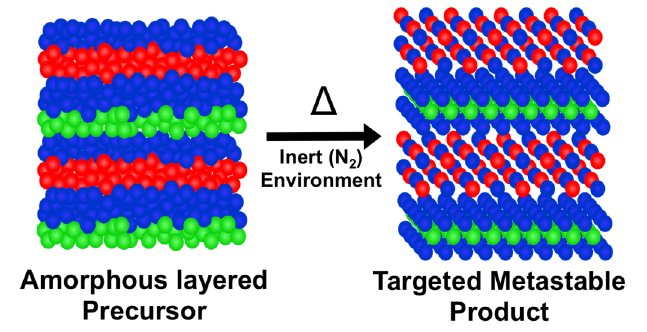
Figure 10. Modulated elemental reactant synthesis. Control of local composition and structure allows for the self-assembly of amorphous precursors into targeted metastable products.